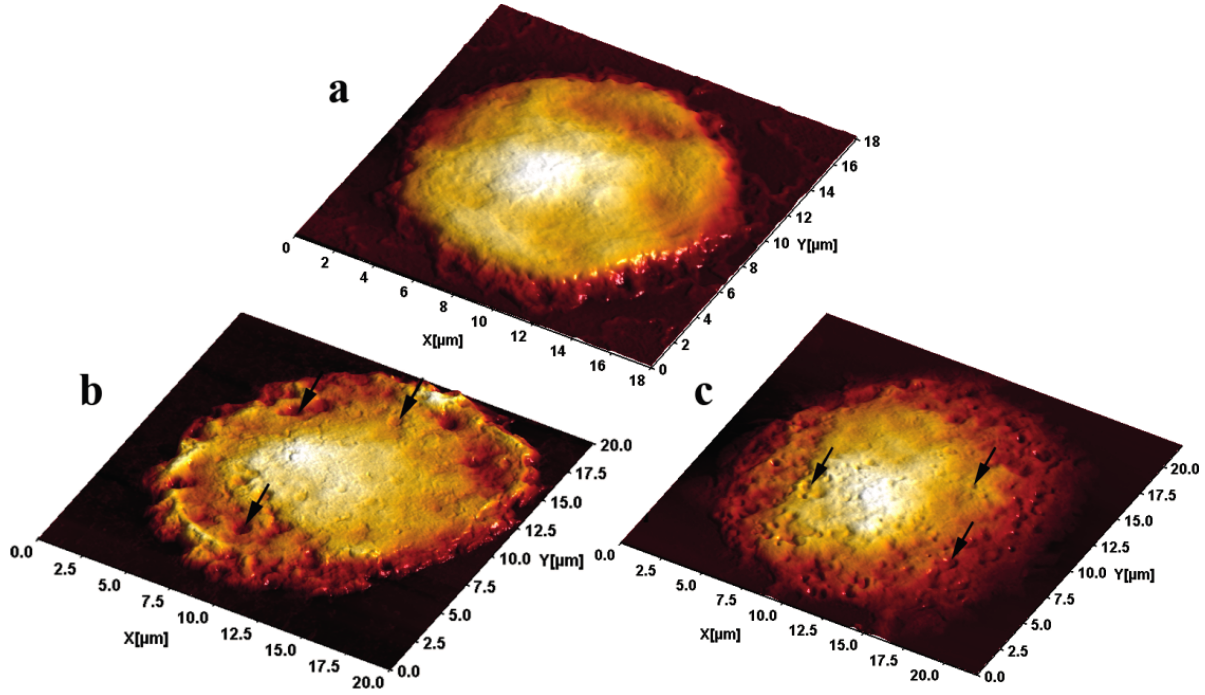
Figure 2. Alveolar macrophage surface topography visualized by the sc-AFM: ( a ) controls; ( b ) after instillation of 340 nm copper oxide-copper particles and ( c ) after instillation of 20 nm copper oxide particles. Typical pits are pinpointed by